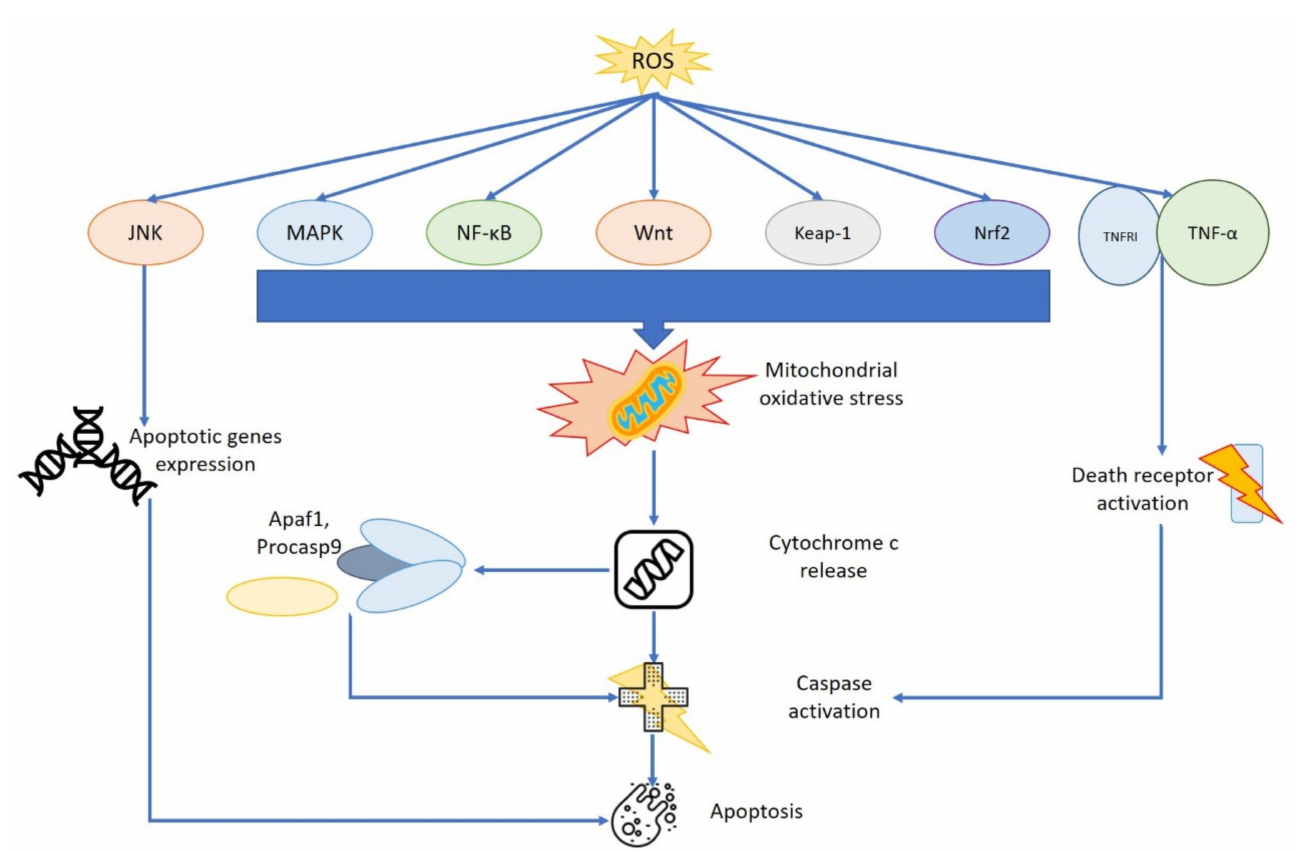
Figure 1. Mechanisms of increased apoptosis as consequence of oxidative stress. Increased concen- trations of ROS stimulate several different pathways able to modify mitochondrial oxidative stress, activate the caspase system, and induce programmed cell death. NF-kB nuclear factor kappa-B; Wnt Wingless and Int-1; Nrf2 nuclear factor (erythroid-derived 2)-like 2; MAPK mitogen-activated protein kinase; Keap1 Kelch-like ECH-associated protein 1; Apaf1 apoptosis protease-activating factor